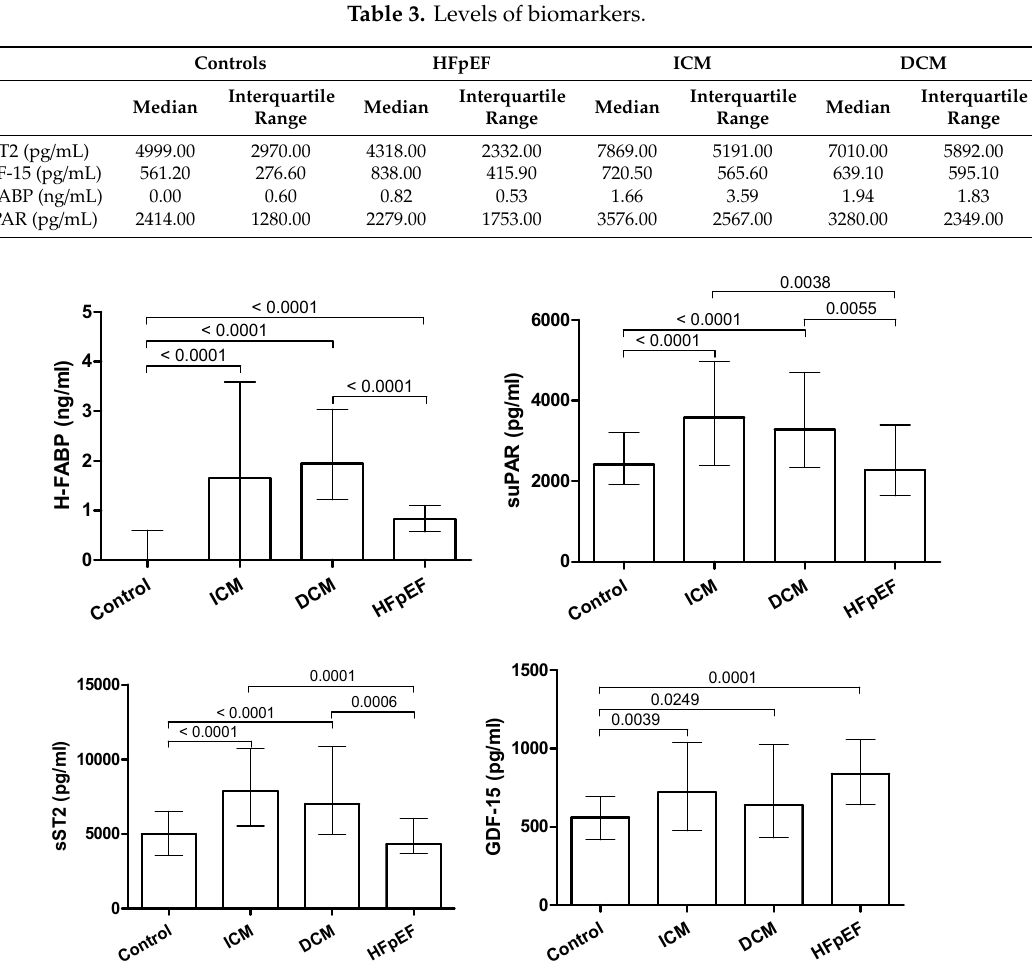
Figure 2. Receiver operating curve 4. Discussion Despite the growing awareness, HFpEF remains a diagnostic and clinical challenge to date. This is partially related to its complex pathophysiology [9]. Given the increasing prevalence of HFpEF and the high rates of misdiagnosis, the need for new diagnostic tools is evident [5]. Accordingly, we aimed